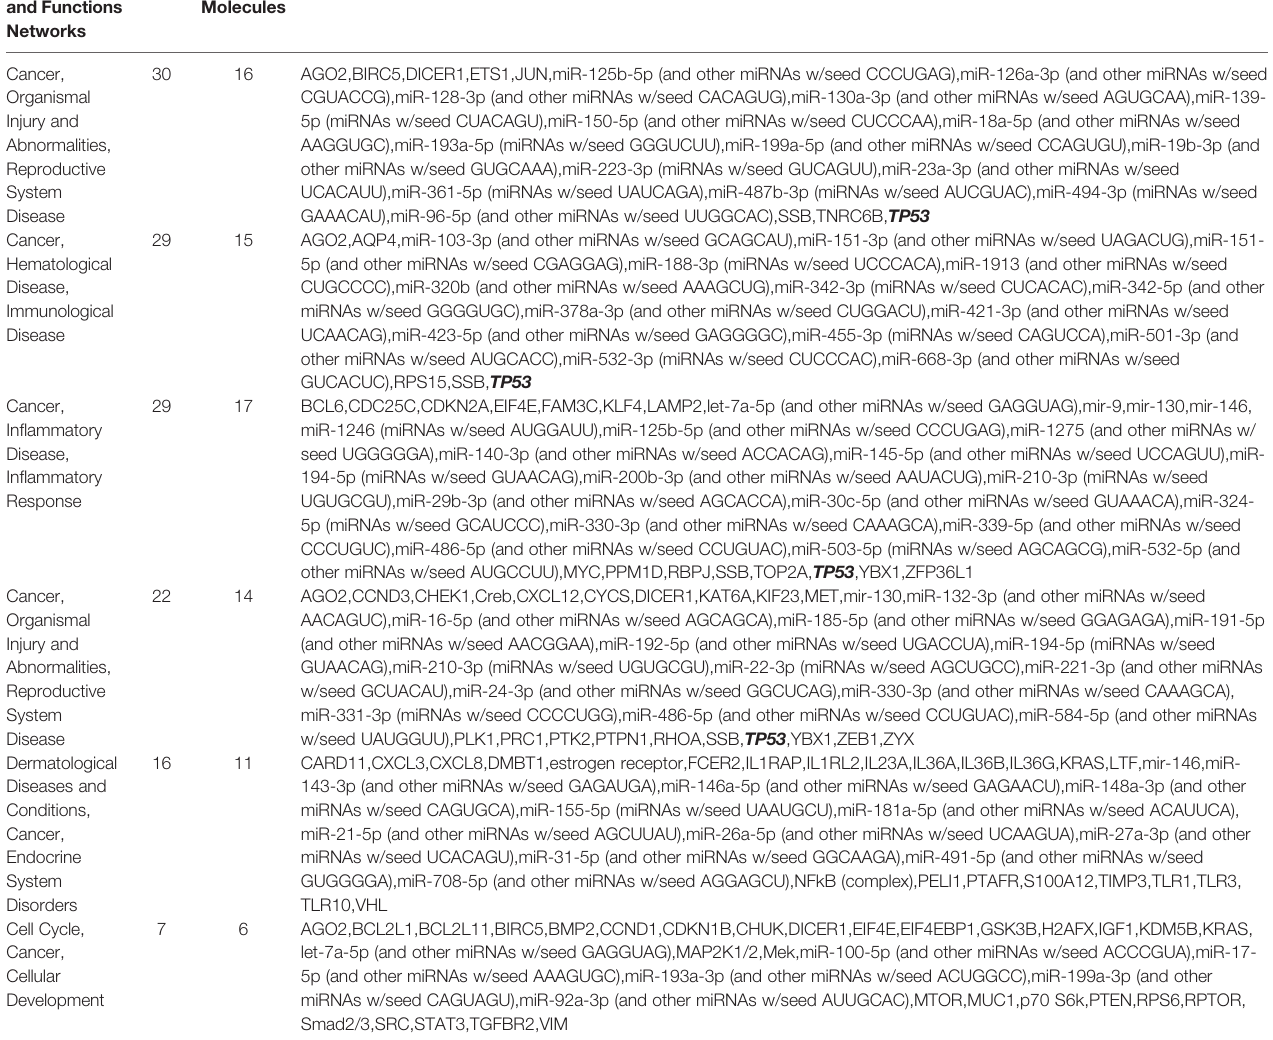
TABLE 2 | IPA-generated networks highlighting dysregulated miRNA and target genes between Control and PTSD samples. Top Diseases and